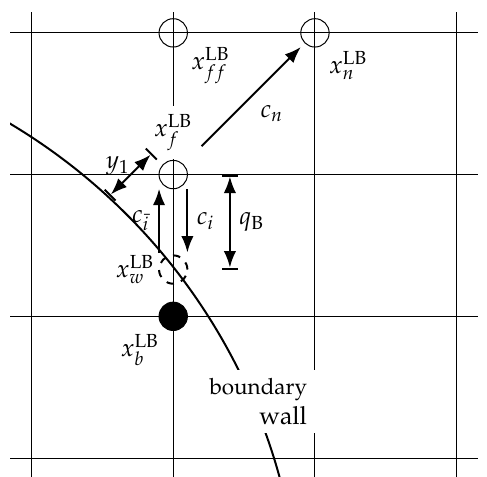
Figure 1. Illustration of the indexing convention for the curved wall function approach applied in this